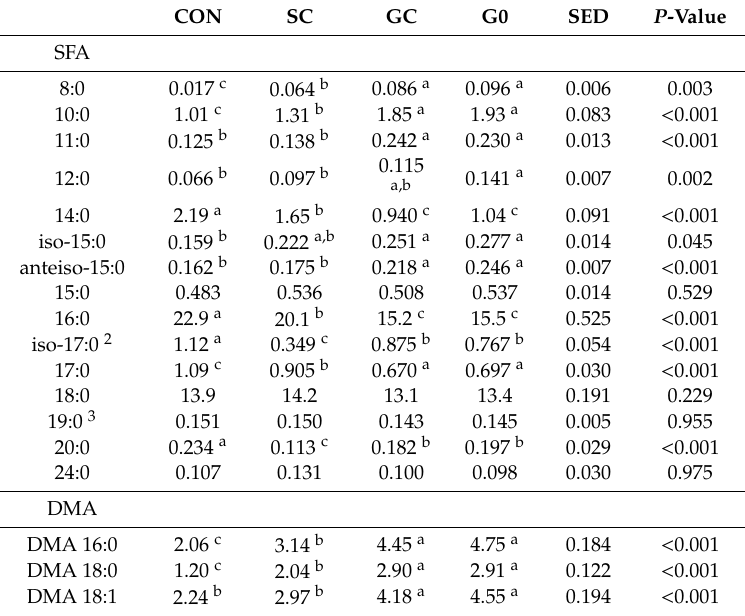
Table 4. Individual saturated fatty acid (SFA) and dimethyl acetal (DMA) proportions (of total fatty acids 1 ) in the longissimus thoracis muscle from bulls assigned to one of the following systems: grass silage plus barley-based concentrate ad libitum (CON); grass silage ad libitum plus 5 kg of concentrate (SC); grazed grass without supplementation (G0) or grazed grass plus 0.5 kg of the dietary dry matter intake as concentrate (GC) until slaughter at 15 months. CON SC